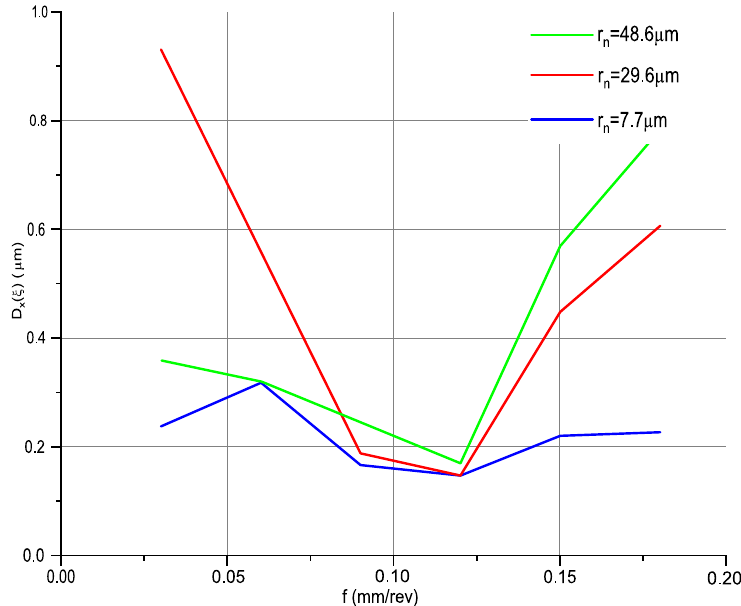
Figure 7. Impact of the feed rate and edge radius on the standard deviation of vibrations generated in the x -axis direction: v c = 360 m/min; f = 0.03 − 0.21 mm/rev; a p = 0.35